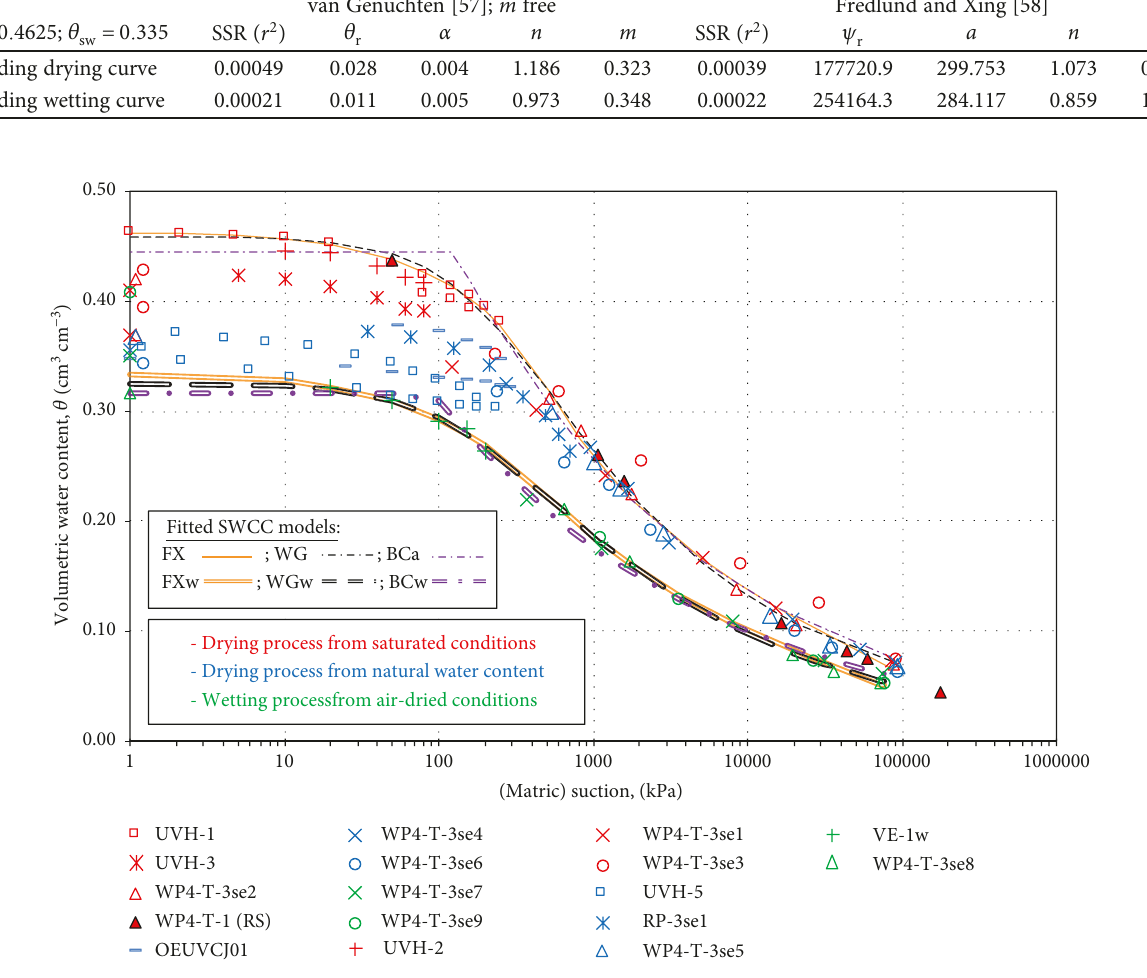
Figure 10: Best- fi t Brooks and Corey [41], van Genuchten [57], and Fredlund and Xing [58] equations plotted with the measurements in ψ - θ